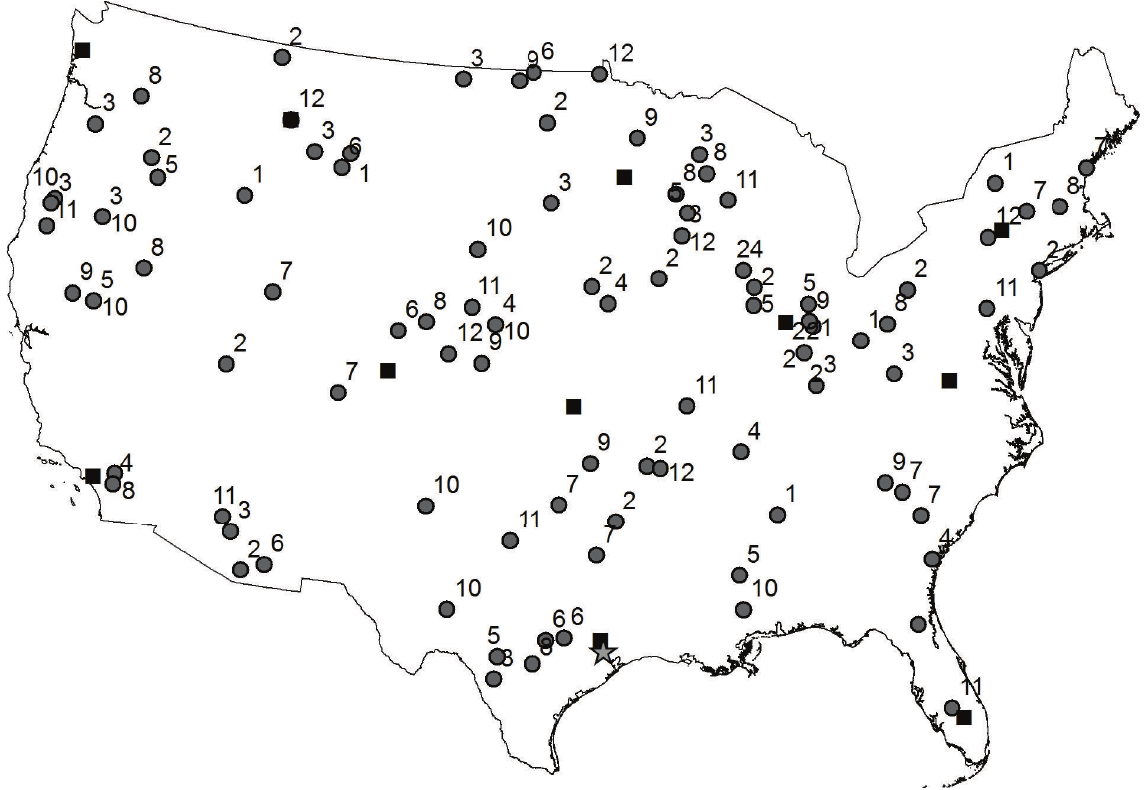
Figure 1: Location of the 104US National Climate Data Center (NCDC) precipitation stations used for the validation of THM in the present study (gray circles). The numbers next to the dots represent the calendar month on which the validation was performed. The locations of the 11 gauges validated by Kim et al. [16] are shown as black squares. The location of the Texas rainfall gauge (NCDC ID 4300) used to generate Figure 3 is also shown (gray